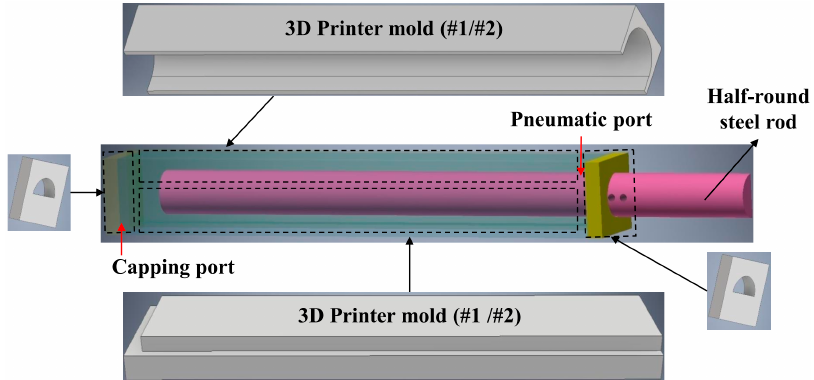
Figure 3. 3D printed mold of the soft actuator.